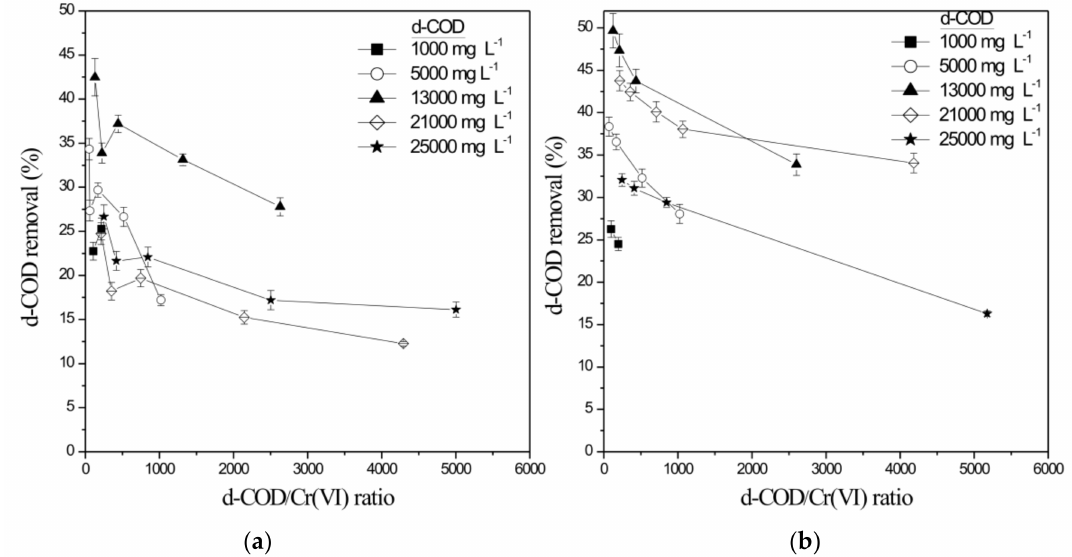
Figure 6. Effect of (initial d-COD)/(initial Cr(VI)) ratio on d-COD removal in the Cr-SCW-filter for various initial d-COD concentrations under SBR mode with recirculation rates of: ( a ) 0.5 L min − 1 and ( b ) 1.0 L min − 1